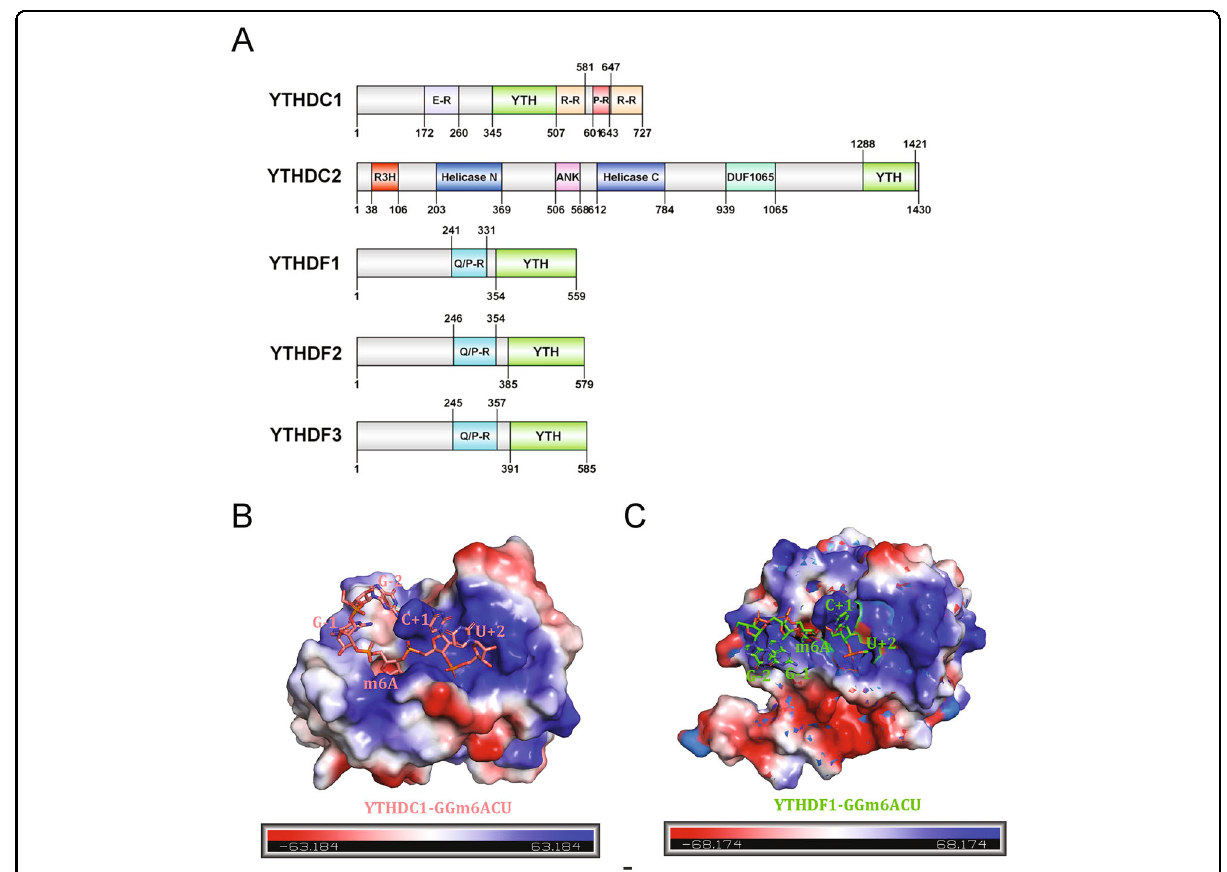
Fig. 2 The YTH domain is usually located in the C terminus of proteins and is rich in basic amino acid residues for RNA binding. A Schematic representation of the protein structure of human YTH domain-containing proteins (YTHDC1, YTHDC2, YTHDF1, YTHDF2, and YTHDF3). B, C The electrostatic potential surface of the YTH domains of YTHDC1 and YTHDF1 in complex with m6A-containing oligonucleotides is represented by PyMOL 2.0. Positive charges are colored blue, neutral charges are white, and negative charges are